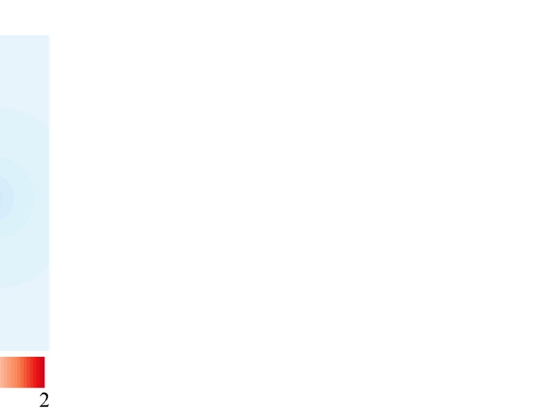
Figure 17. Pressure contour plots of two flat-plate wings with a smaller distance in between ( W / c =